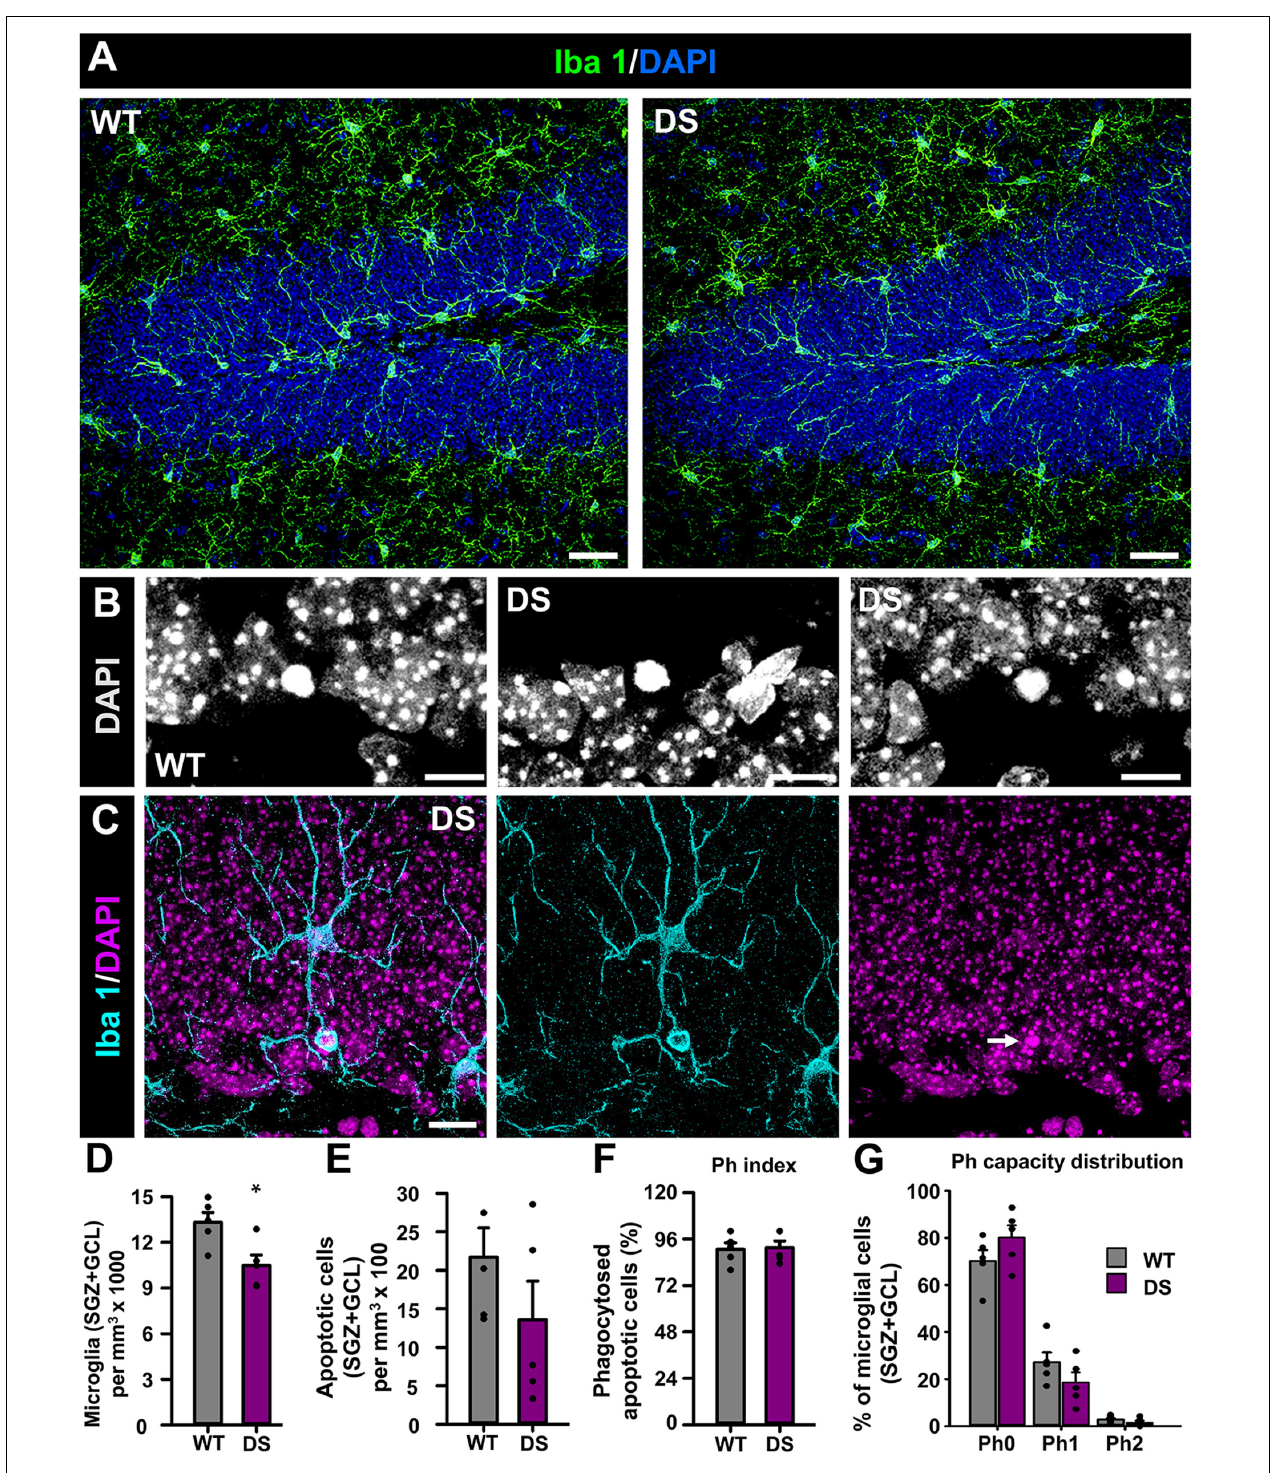
FIGURE 4 | Alteration of microglia in DS mice. (A) Confocal-microscopy images of the DG of WT (left) and DS (right) immunostained for Iba 1 (a specific marker of macroglia in the brain) and stained for DAPI. DAPI DNA staining was used to identify apoptotic (condensed) nuclei at higher magnification (B) . Phagocytosis was identified as microglial pouches extended form microglia cells (Iba 1 + ) wholly engulfing apoptotic nuclei (C) . There were fewer microglia in the SGZ+GCL of DS mice (D) . The number of apoptotic nuclei did not change from WT to DS mice (E) . The number of apoptotic cells being engulfed by microglia was not altered either (F) . There were not changes in the proportion of microglia with either none, 1, or 2 phagocytosing poaches (Ph) (G) . * p < 0.05 by Student’s t -test in (D) . n = 5 for each condition. Bars show mean ± SEM. Dots show individual data. Scale bar in (A) is 40 µ m, 10 µ m in (B) , and 20 µ m in (C) .